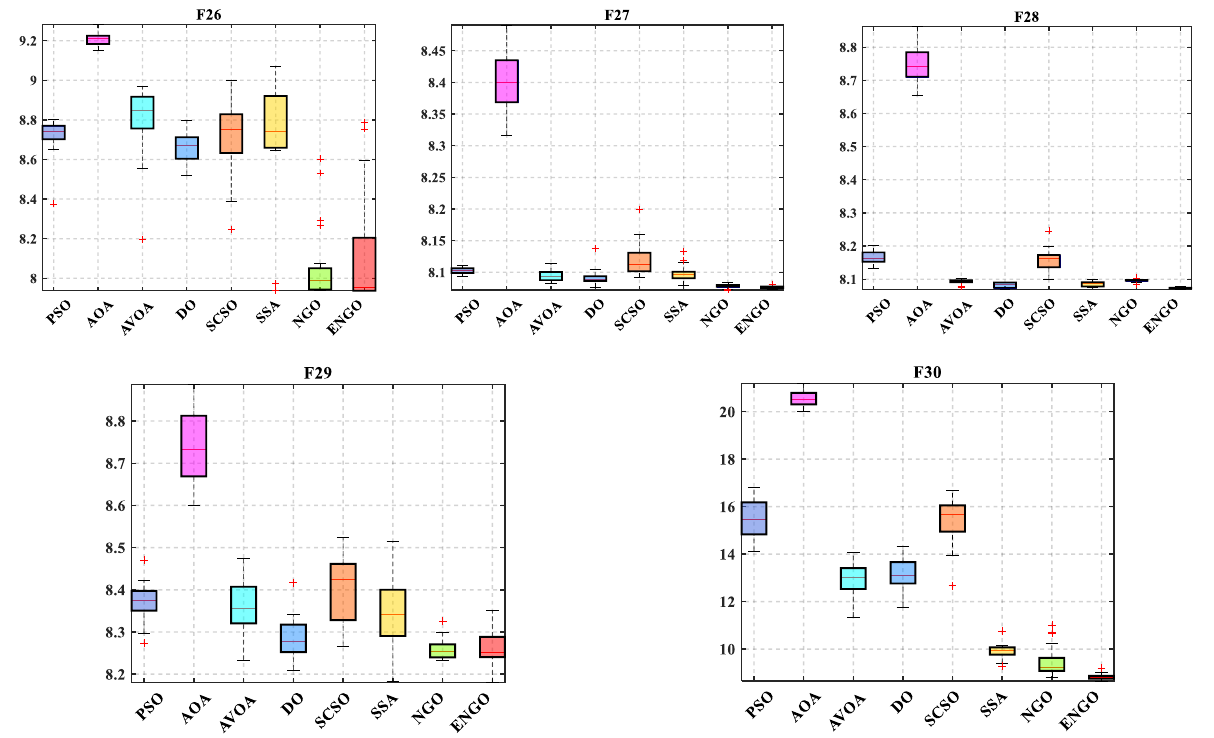
Figure 7. The boxplots of the different algorithms on CEC2017.